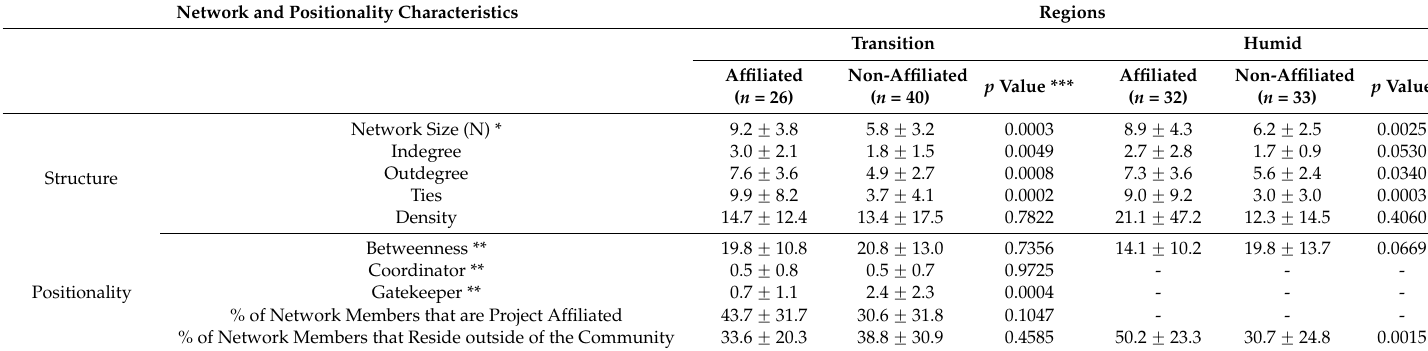
Table 2. Mean ( ˘ SE) network structure and farmer positionality values for male and female farmers in the Transition and Humid regions. Network and Positionality Characteristics